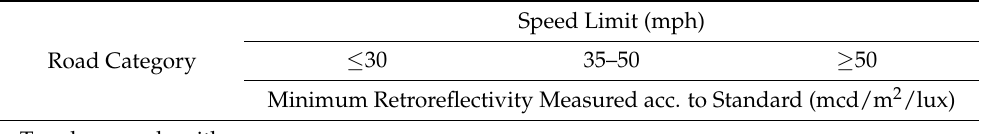
Table 1. Retroreflectivity limits set by the federal highway administration (FHWA) in The Manual on Uniform Traffic Control Devices